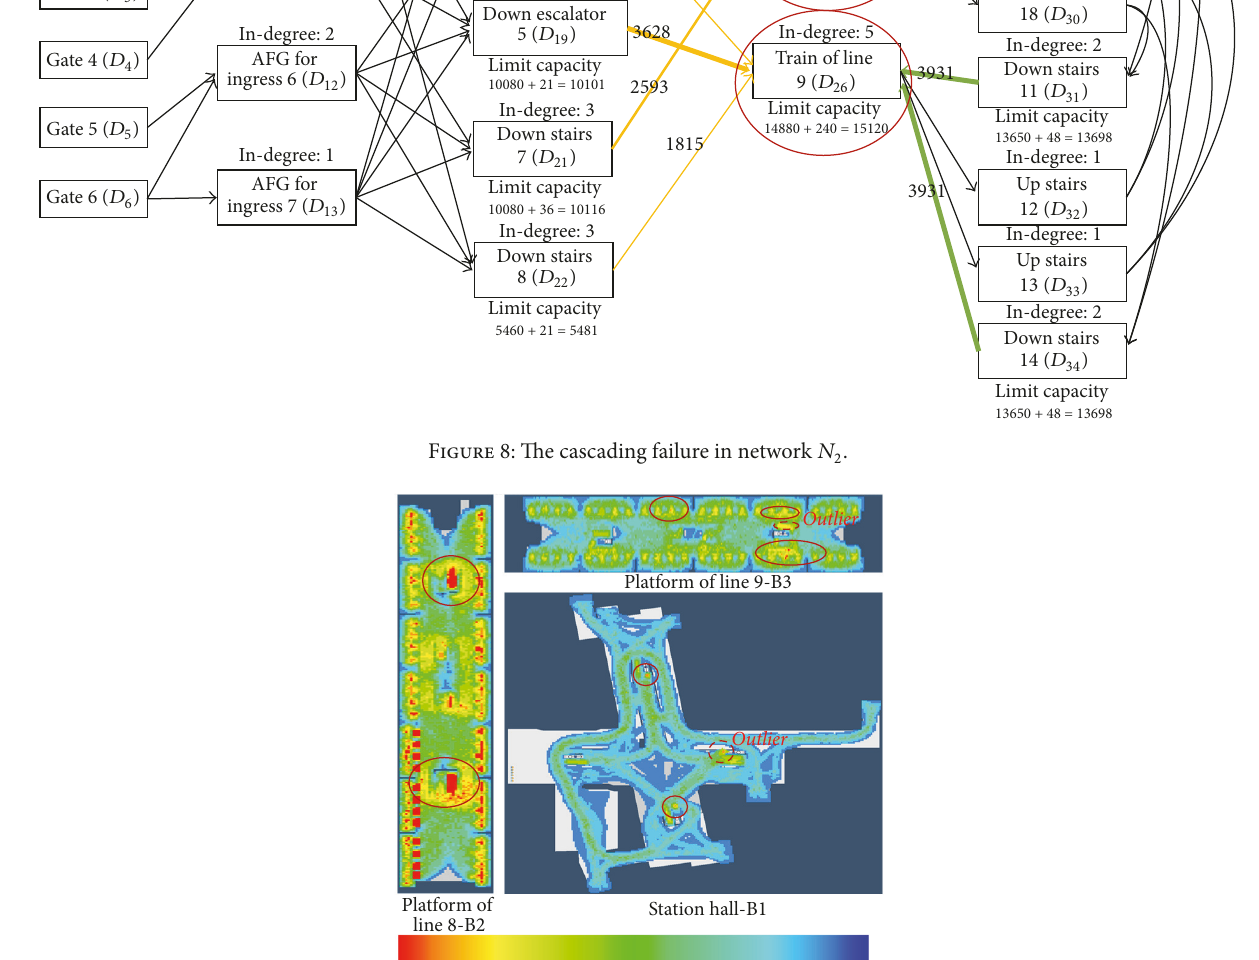
Figure 9: The density map exported from